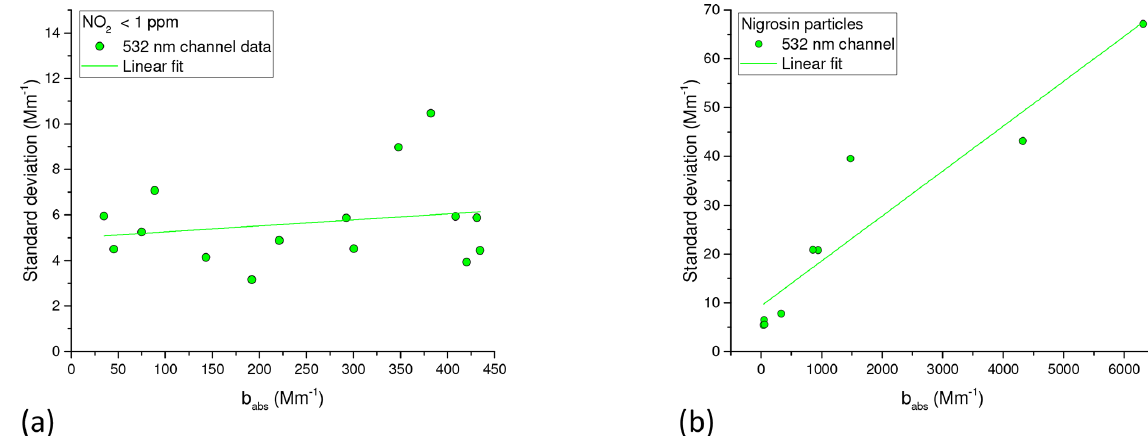
Figure 12. Standard deviation of the 532nm channel data during measurement of NO 2 (a) and nigrosin (b)